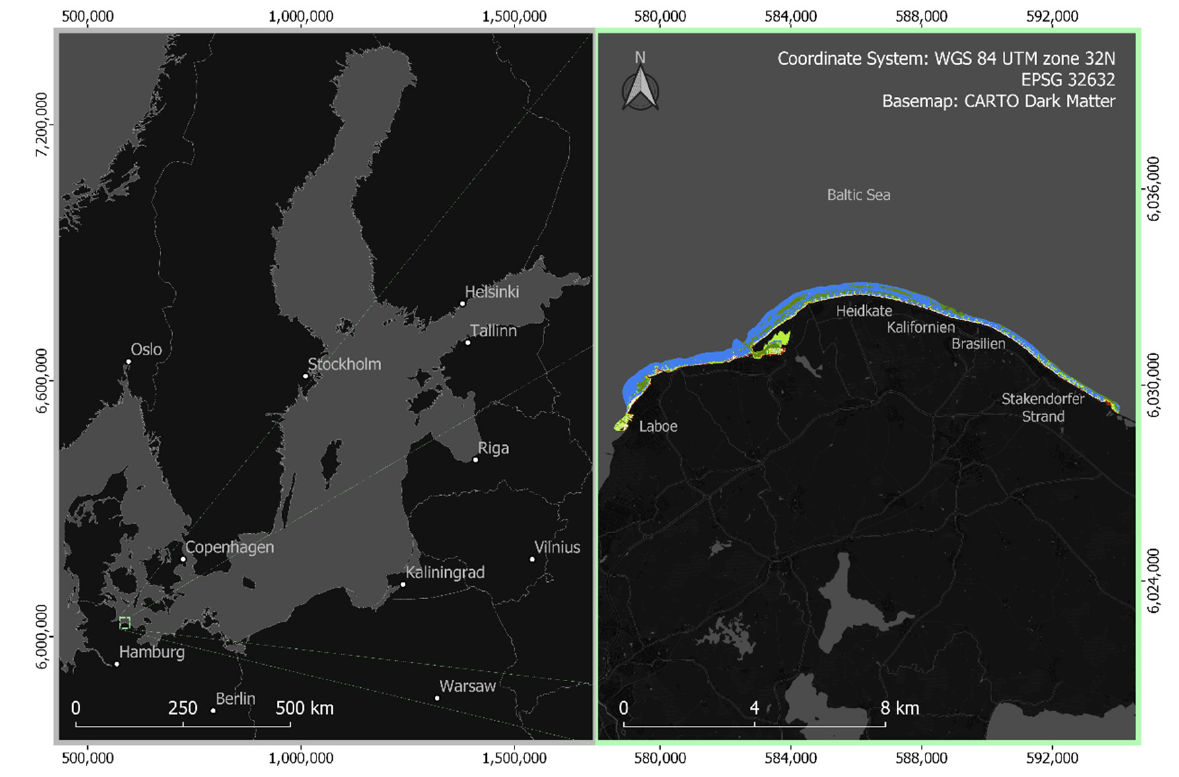
Figure 1. Location of the study area.